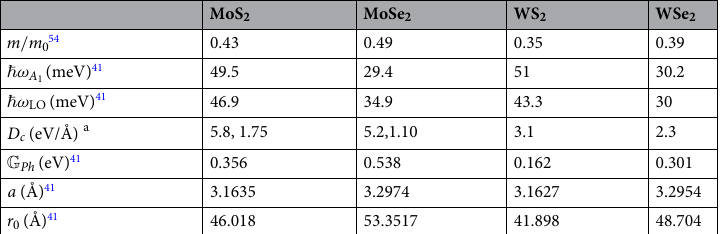
Table 1. Employed parameters for the calculation of the energy spectrum from the set of Eqs. (6) and (7). The value of δ/ (cid:31) ω A 1 = 0.02 is used. a is the lattice constant and G Ph is the PF coupling constant of Eq. (19). a The highest D c values of 5.8 eV/Å and 5.2 eV/Å for MoS 2 and MoSe 2 , respectively, were obtained adjusting the ab initio calculations with the relaxation time 40 . The values of 1.75 eV/Å and 1.10 eV/Å were derived by employing the pseudopotential method 47 . This large variation in values for D c makes a marked difference in the resulting MP spectrum, in particular, in the relative contribution of the PF and DP interactions to ˆ ǫ and Ŵ . In the present calculations, the values of 5.8 eV/Å and 5.2 eV/Å are